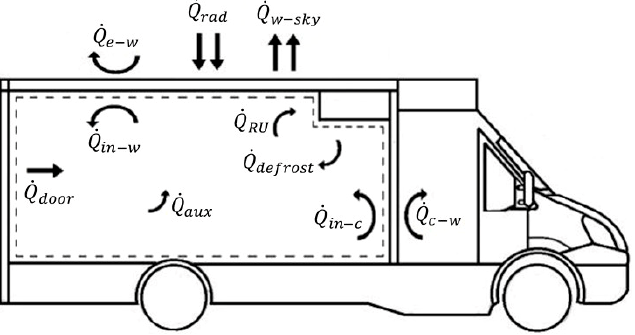
Figure 2. Heat flow schematic .